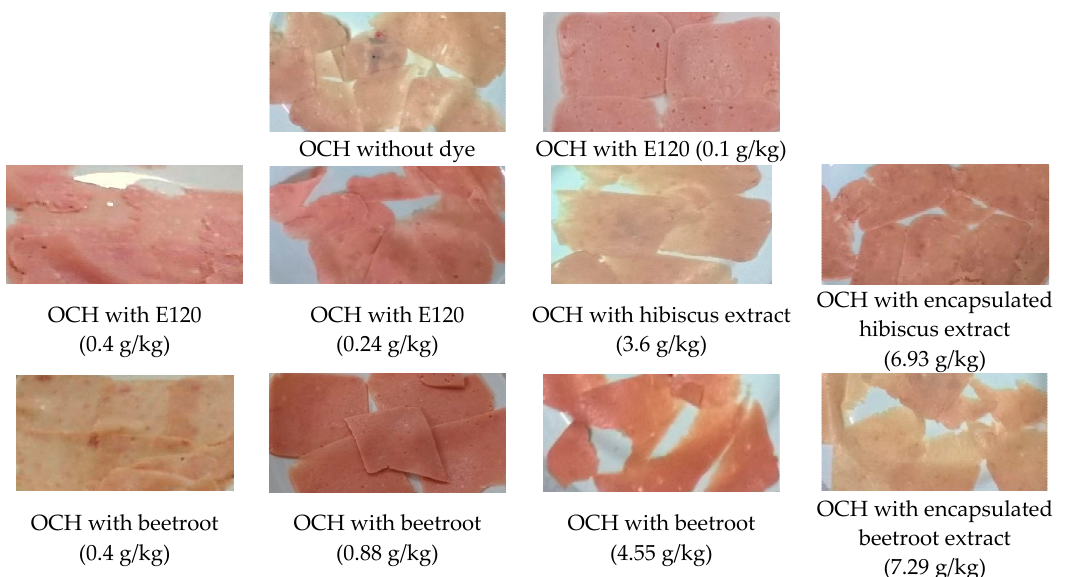
Figure 6. Samples in slices from the pilot scale ordinary cooked ham (OCH) obtained without dye, with E120, and the non-encapsulated and encapsulated extracts of hibiscus and red beetroot with various concentrations.